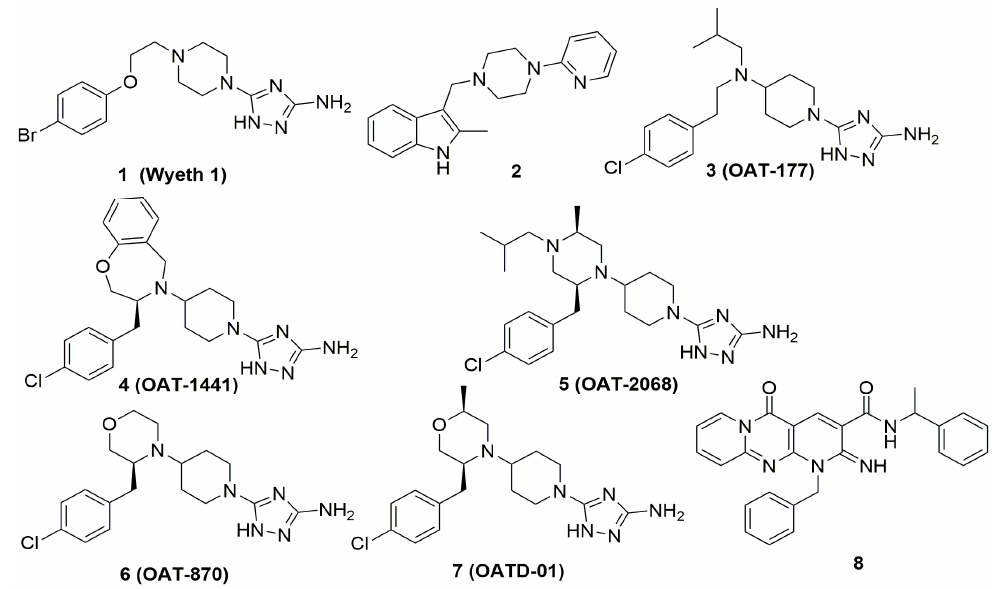
Figure 3. Examples of drug-like chitinase inhibitors.